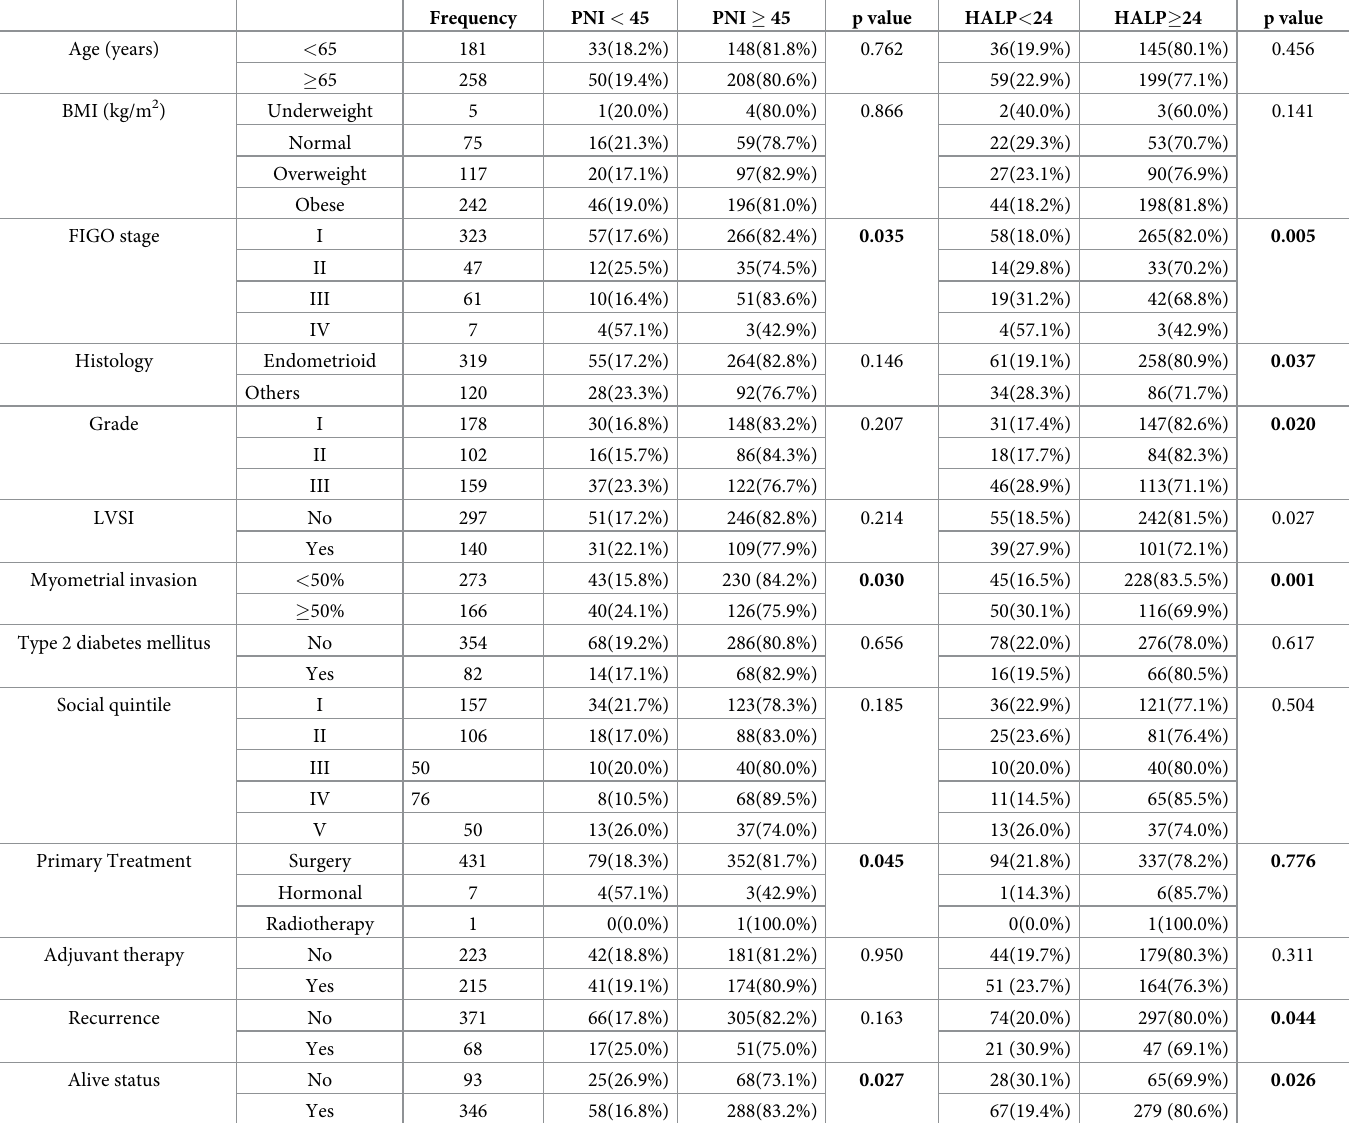
Table 2. Socio-demographic characteristics stratified by prognostic nutritional index (PNI) and haemoglobin, albumin, lymphocyte and platelet (HALP) score